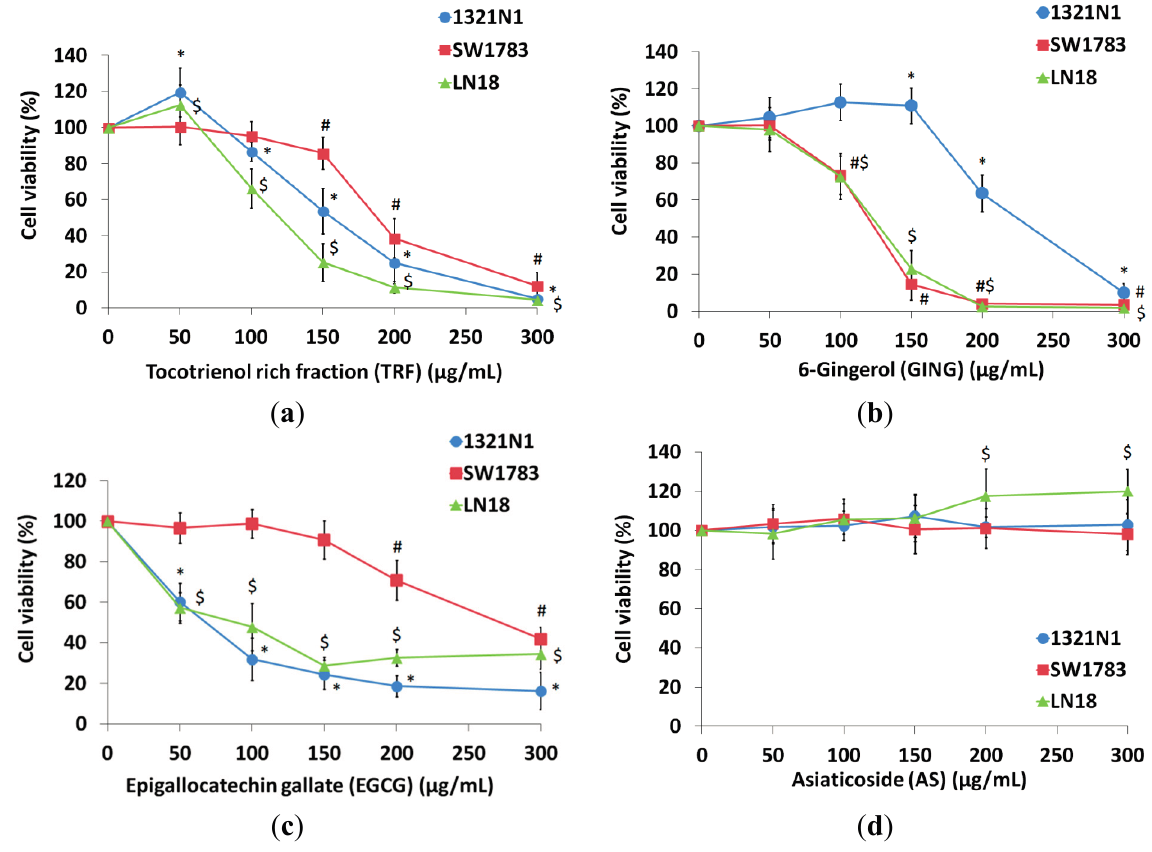
* p < 0.05 compared to the untreated 1321N1; # p < 0.05 compared to the untreated SW1783; $ p < 0.05 compared to the untreated